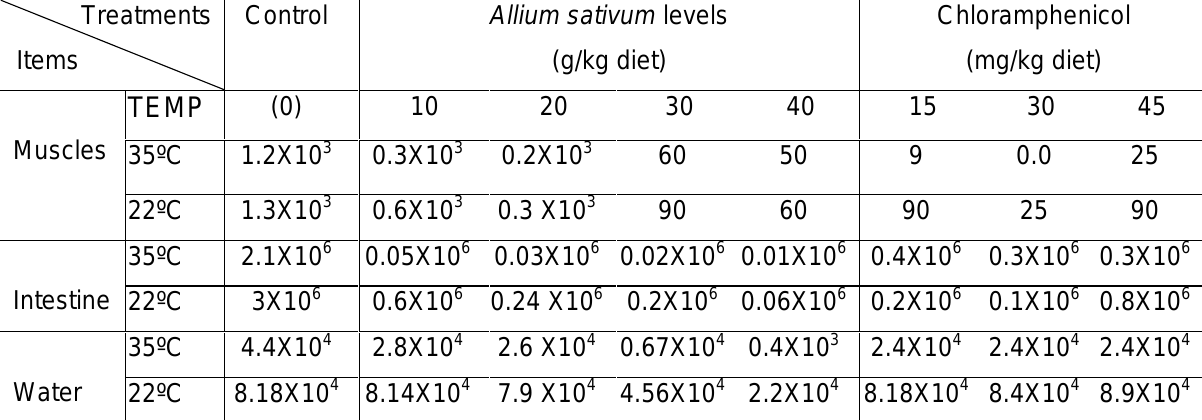
Table 9: Effects of Allium sativum and chloramphenicol on total bacteria from muscles, intestine and water among treated O. niloticus .